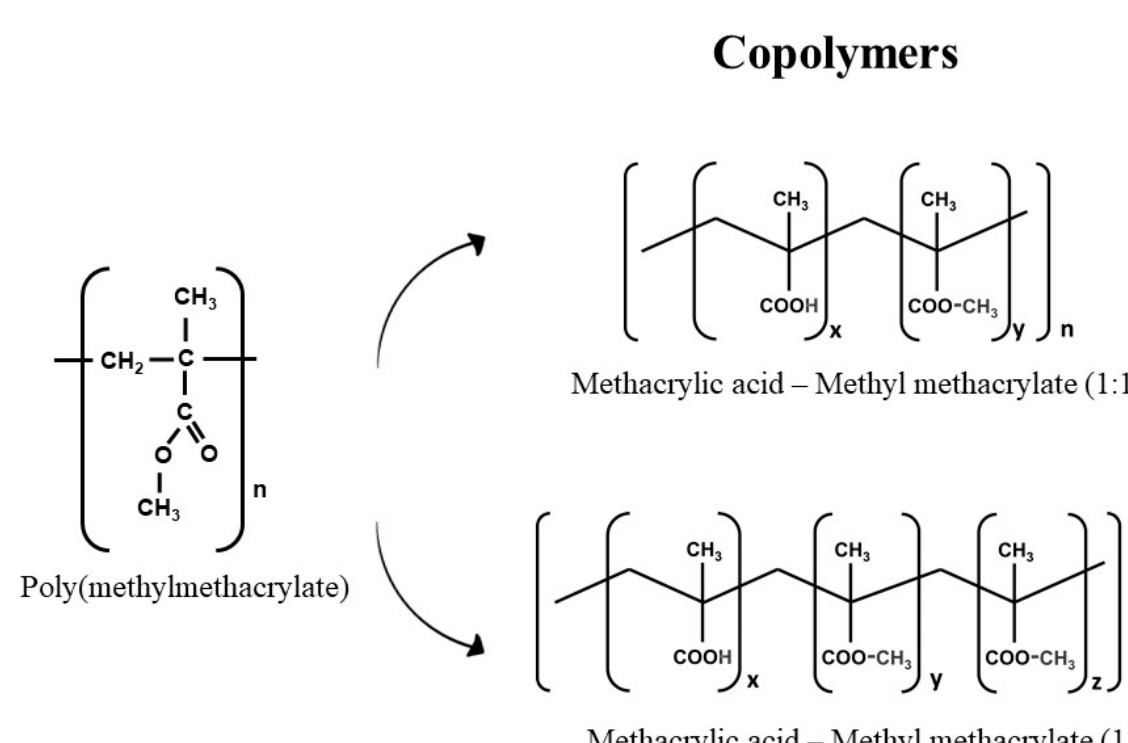
Figure 2. Representation of polymers that share the same generic formula. R*: Free radical.